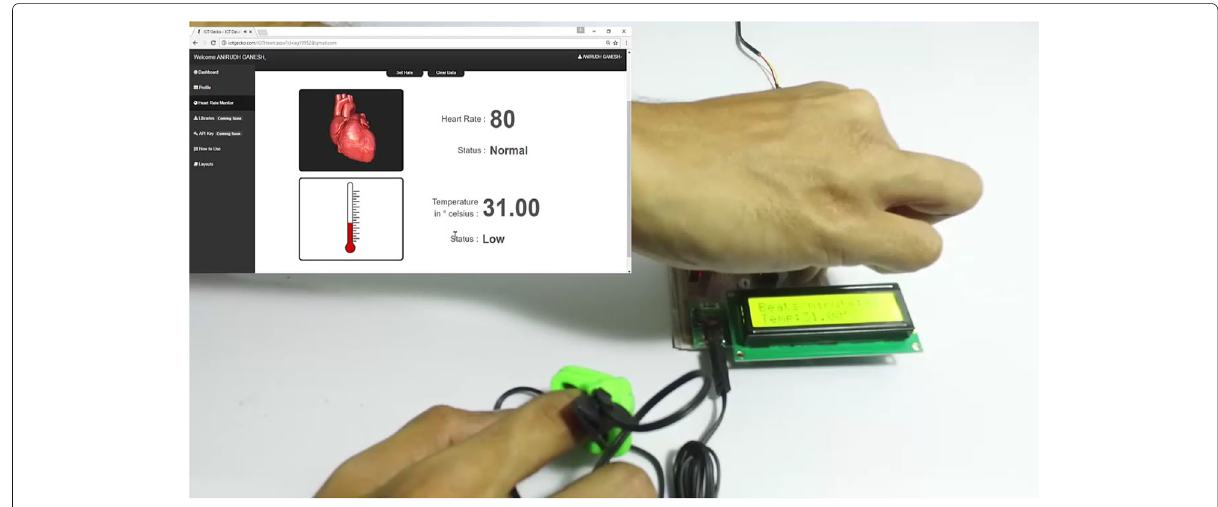
Fig. 6 The WISE-Cloud for authorised users to access data